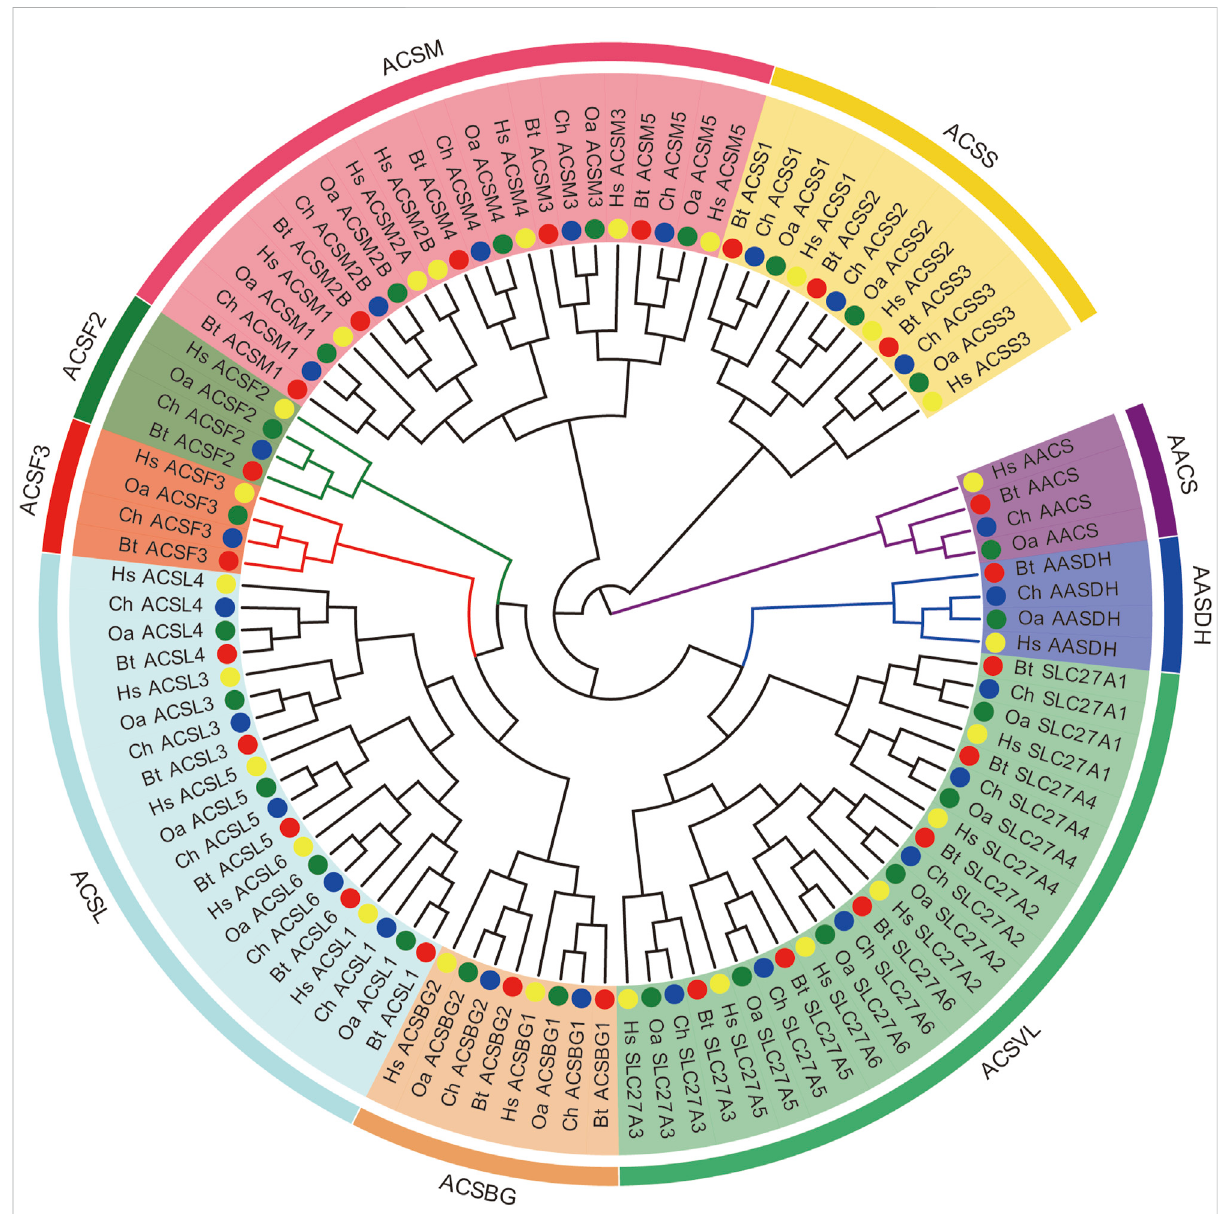
FIGURE 1 Phylogenetic tree ofACS proteinsfrom Capra hircus , Homo sapiens , Ovis aries , and Bos taurus . Legends: The tree was generated using the IQ- TREE with an ultrafast bootstrap value of 1,000. Each ACS subfamiliy is marked by a different colour. Note: Ch, Capra hircus ; HS, Homo sapiens ; Oa, Ovis aries ; Bt, Bos taurus